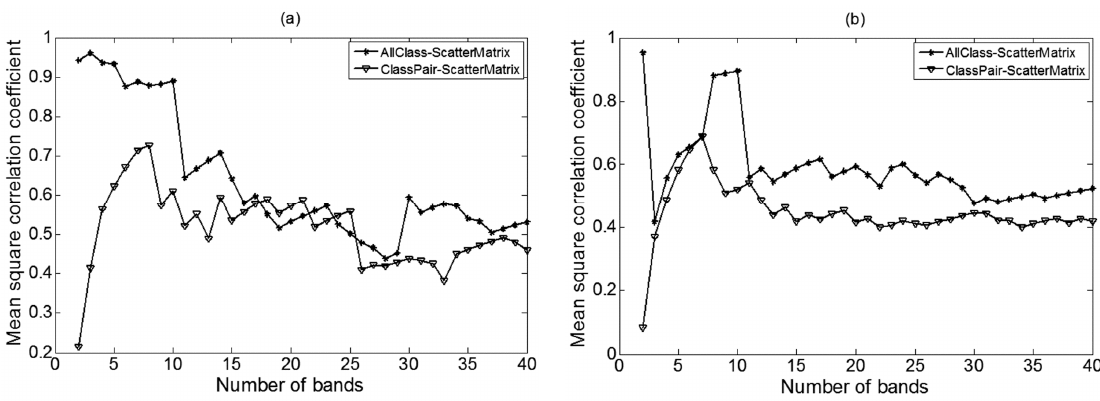
Figure 3. Mean square correlation coefficient for the ClassPair_ScatterMatrix method and AllClass_ScatterMatrix method versus the number of selected spectral bands on ( a ) data set 1; ( b ) data set 2.